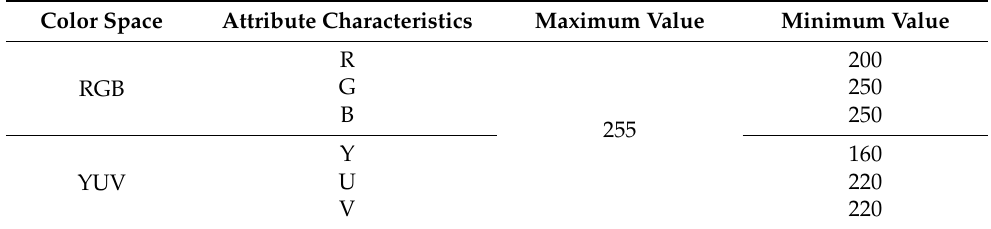
Table 2. Summary statistics of the trees and fruits of the oil tea in the study